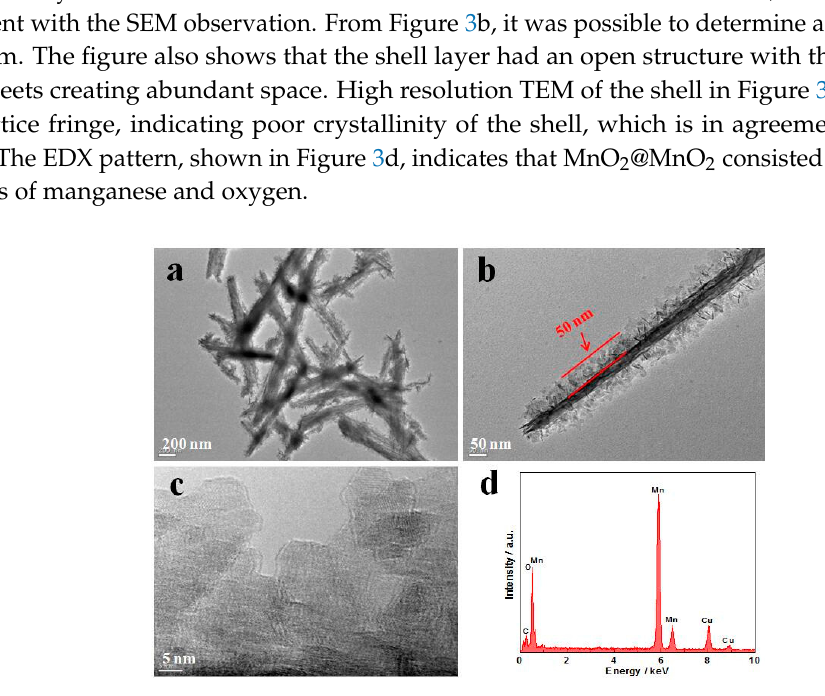
Figure 3. ( a – c ) TEM images with different magnification; and ( d ) EDX (Energy-dispersive X-ray) spectrum of MnO 2 @MnO 2 .